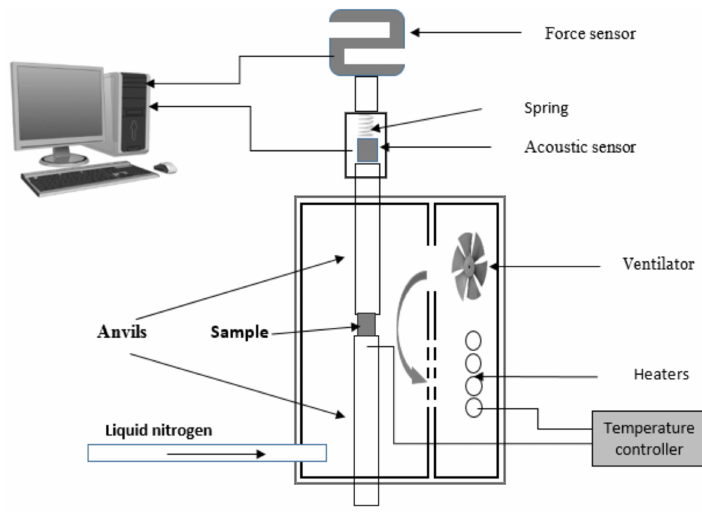
Figure 1. Experimental